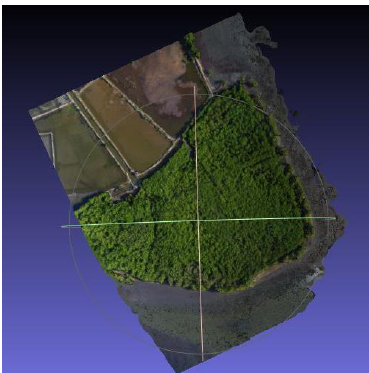
Figure 3. 3D model of a mangrove forest in Banate Bay, Iloilo generated from UAV images